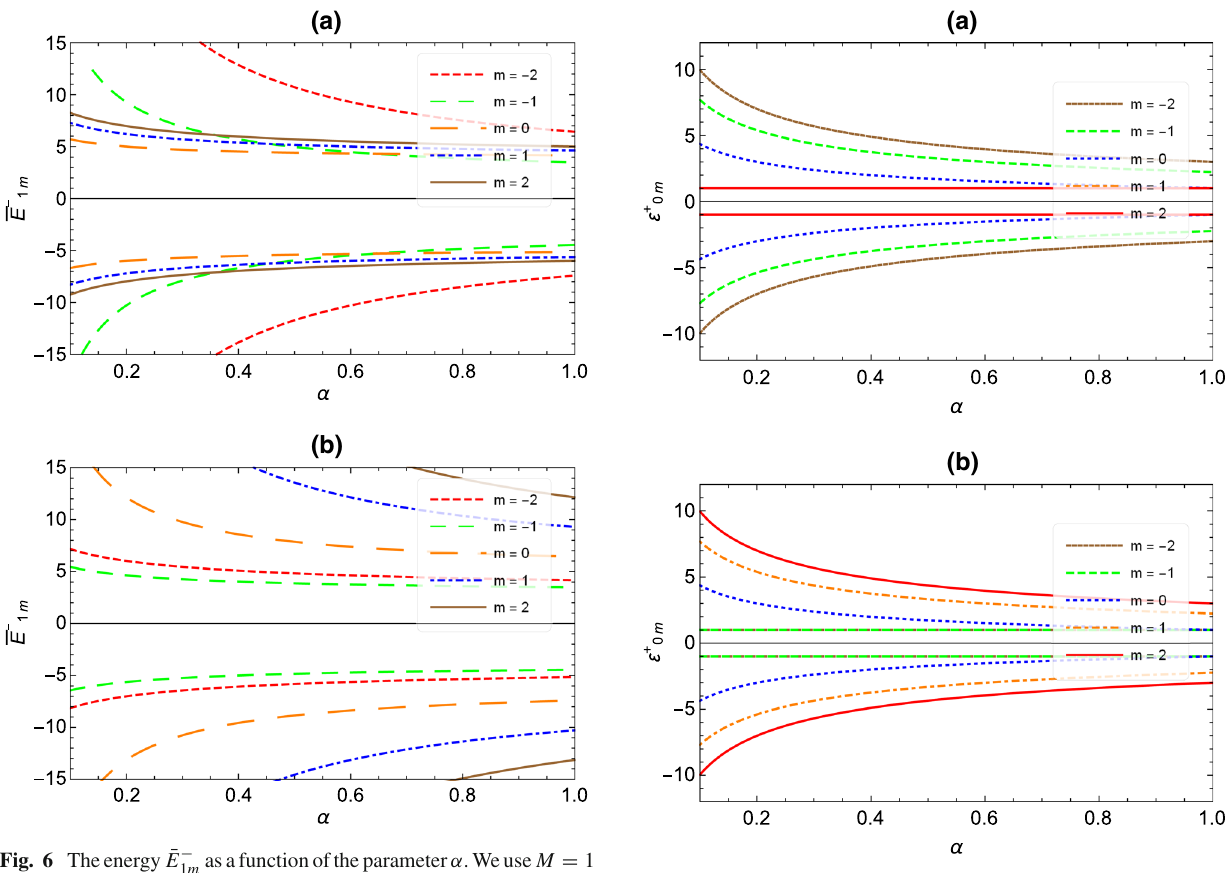
Fig. 7 The energy (cid:20) + as a function of the parameter α . In a the plot 0 m for s = 1 and b for s = − 1. We use M = 1. In a , the states with m (cid:3) 0 are more affected by curvature while the states with m (cid:2) 1 are degenerate and are not affected by curvature. In b , we have the situation opposite to a : the states with m (cid:2) 0 are most affected by curvature and states with m (cid:3) − 1 are degenerate and are not affected by curvature